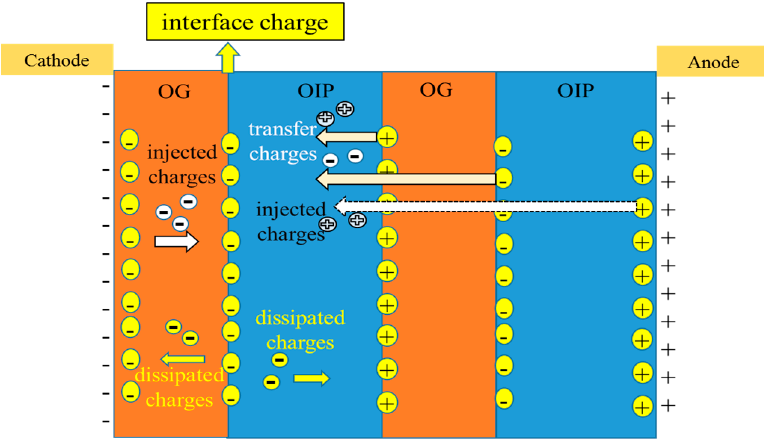
Energies 2017 , 10 , x FOR PEER REVIEW Figure 7. Schematic diagram of interfacial charge accumulation and migration. Figure 7. Schematic diagram of interfacial charge accumulation and migration.